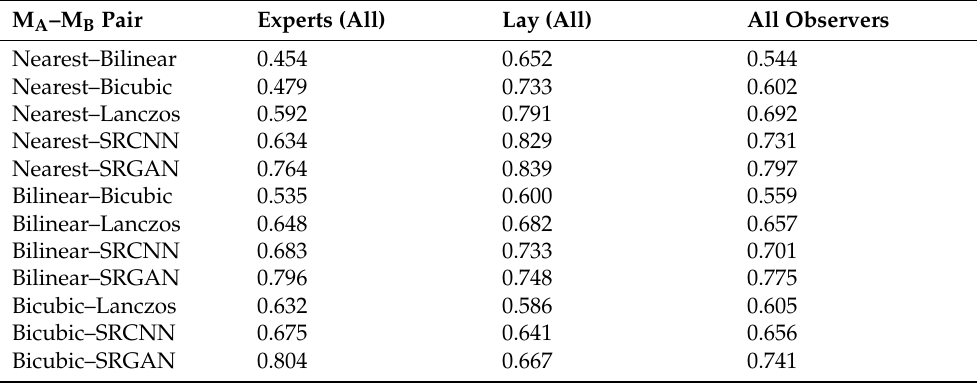
Table 2. Values of area under the curve (AUC) achieved for each M A –M B considering all participants, and the expert and lay participant